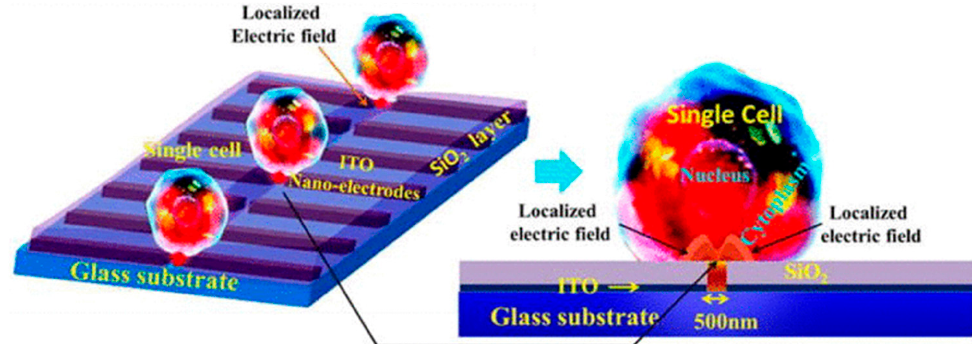
Figure 14. Schematic diagram of LSCMEP platform. The applied electric field porates a small area of the cell membrane for delivery of the drug into the cell. Reproduced with permission from ref. [113]. Copyright © 2014 The Royal Society of Chemistry.